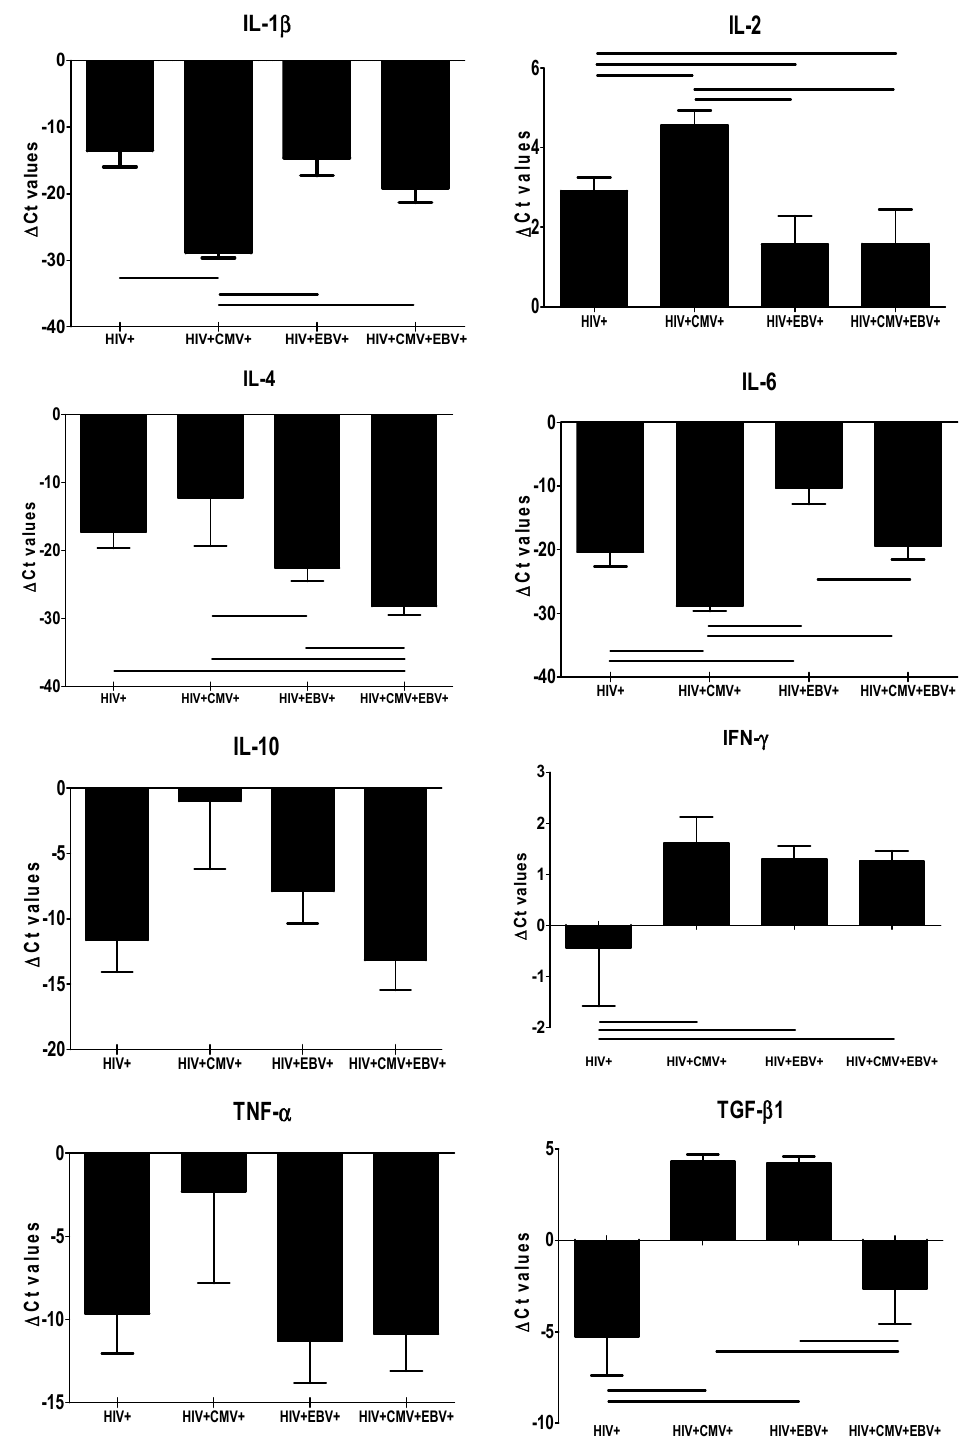
Figure 1. Mean ∆ Ct values of different cytokines in all four groups. The ∆ Ct values for different pro- and anti-inflammatory cytokines in HIV mono-infected and HIV–CMV, HIV–EBV, and HIV–CMV–EBV co-infected groups are shown. Solid lines above bars indicate a statistically significant difference ( p < 0.05).